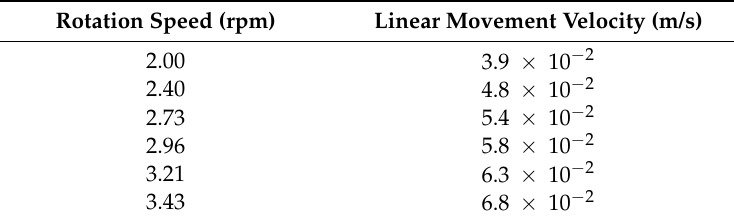
Figure 7. A schematic of the experimental setup. Table 1. Wheel rotation and the linear velocities of the